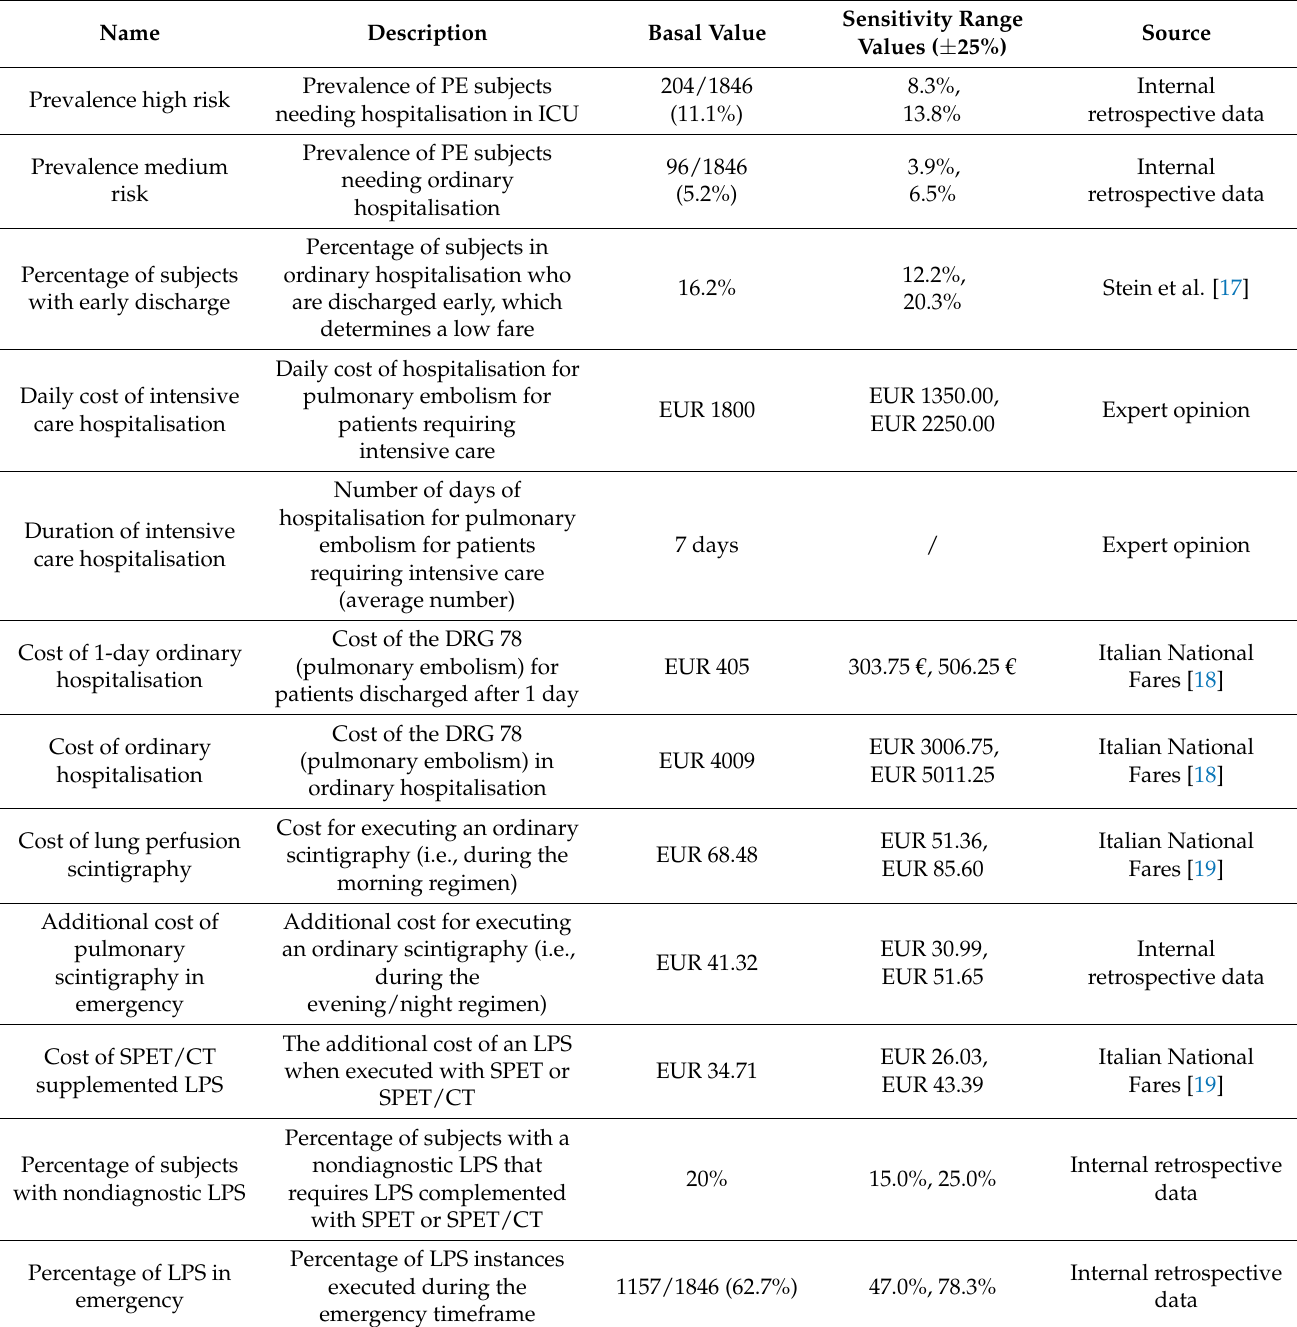
Table 1. Parameters adopted in the economic